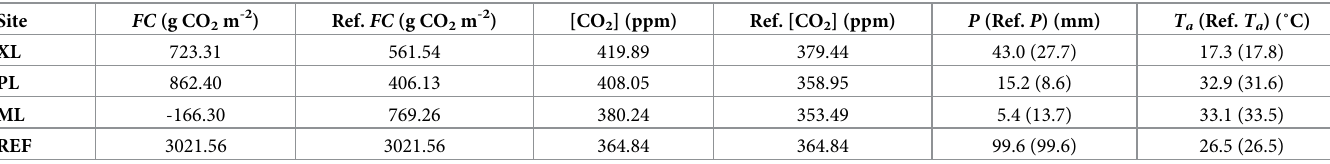
Table 3. Total FC , average [CO 2 ], precipitation and air temperature during each deployment and for the simultaneous period at the REF site (labeled as Ref.).